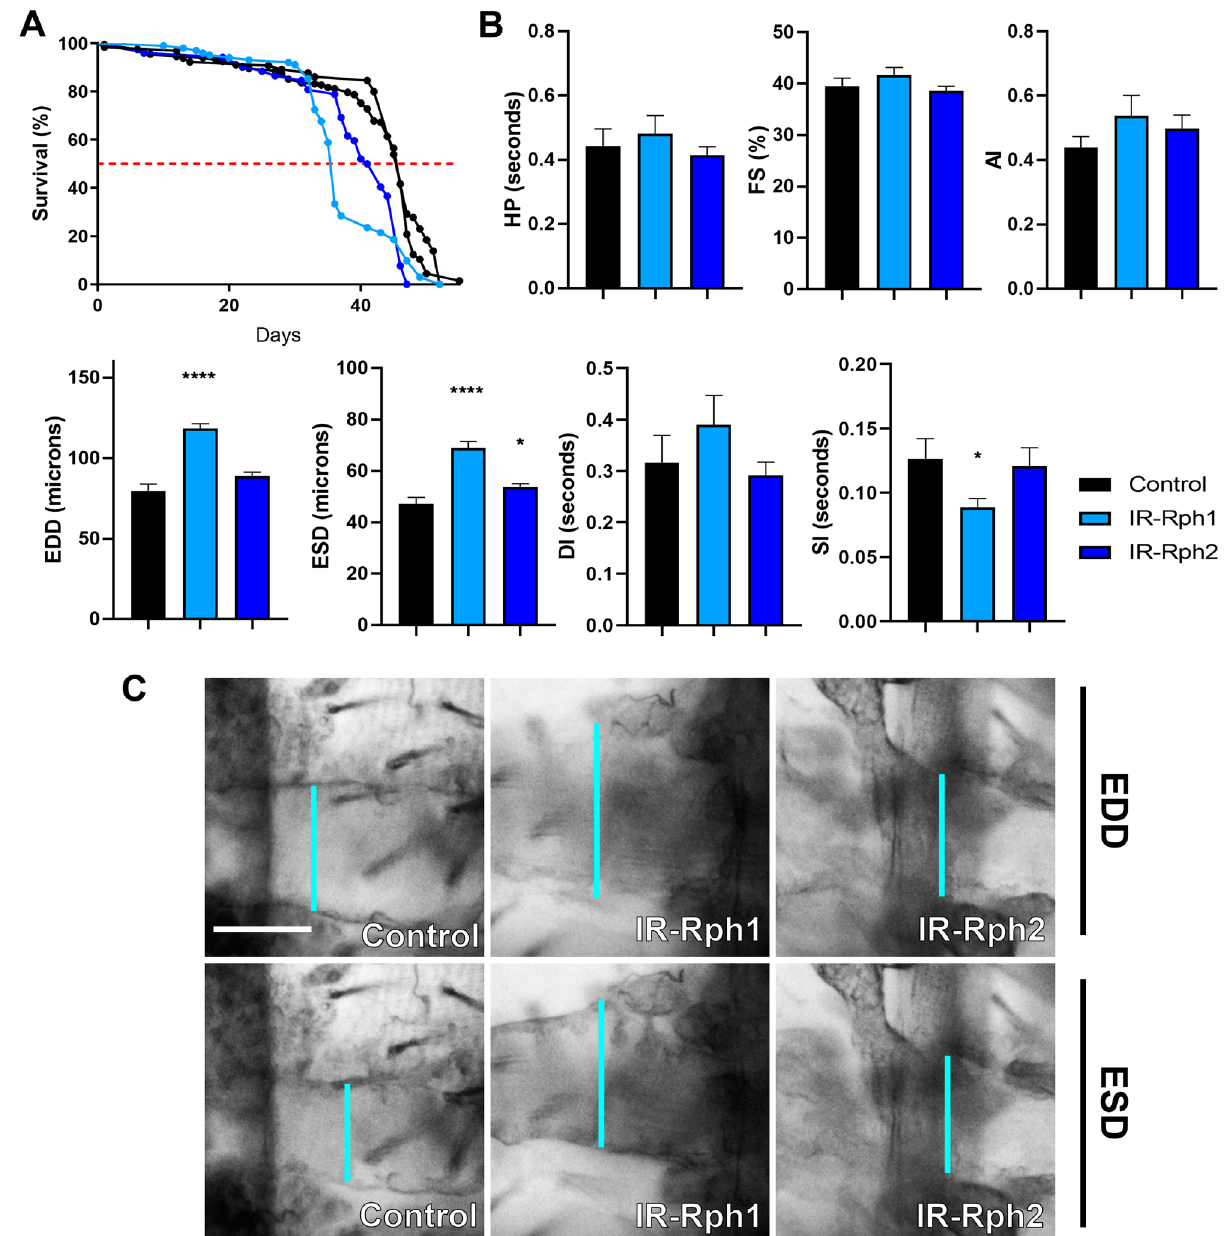
Figure 5. Cardiomyocyte-specific silencing of Rph produces cardiac dysfunction in adult flies. ( A ) Survival curves of control ( GMH5-Gal4 UAS-GFP > UAS-IR-bcd and GMH5-Gal4 UAS-GFP > yw black lines) and Rph RNAi knockdown (blue lines) flies under the control of the GMH5-Gal4 driver. ( A ) The Rph silencing in cardiomyocytes impaired survival of adult IR-Rph flies. The horizontal red line marks the median survival. ( B ) Adult heart function parameters represented as column bar graphs. ( C ) Representative micrographs of dissected fly abdomens showing heart tubes in the diastolic and systolic phases. Blue lines mark the distance between the heart walls in diastole and systole phases (EDD and ESD, respectively). The genotype of the control flies in B , C is GMH5-Gal4 UAS-GFP > yw Scale bar = 50 µm. Statistics results: log-rank (Mantel-Cox) test for survival: p value < 0.0001. Student’s t-test. * p value < 0.05, **** p value <